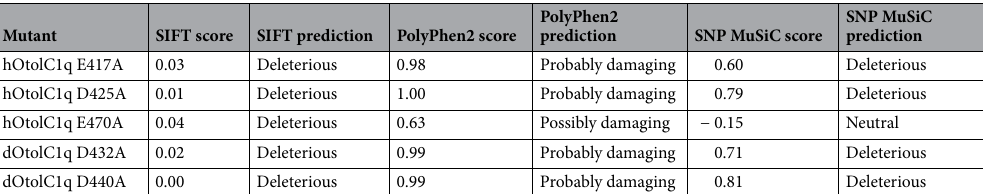
Table 1. Predicted effects of mutations of hOtolC1q and dOtolC1q. The predictions were made using SIFT (https:// sift. bii.a- star. edu. sg/) 62 , PolyPhen2 (http:// genet ics. bwh. harva rd. edu/ pph2/) 63 and SNPMuSiC (https:// soft. dezyme. com/) 64 . SIFT score has a scale from 0 to 1. Variants with scores below 0.05 are predicted to be deleterious. PolyPhen2 score has a scale from 0 to 1. Variants with scores up to 0.446 are predicted to be benign, from 0.447 to 0.908 to be possibly damaging, and with scores higher than 0.908 to be probably damaging. SNPMuSiC: positive score predicts the variant to be deleterious, negative to be neutral.